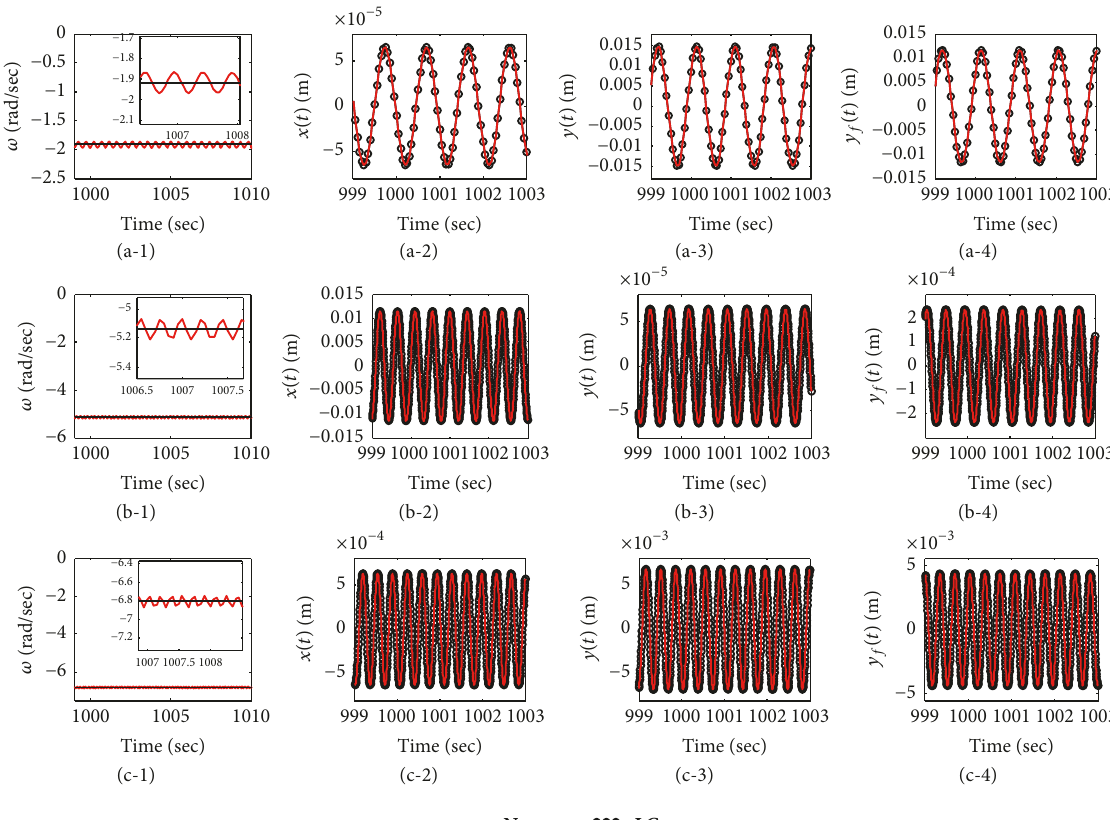
Figure 4: Comparison between analytical limit cycle solution and numerical simulation on time domain ((a-1) through (a-4) at Ω = 1.27 , (b-1) through (b-4) at Ω = 2.93 , and (c-1) through (c-4) at Ω = 3.79